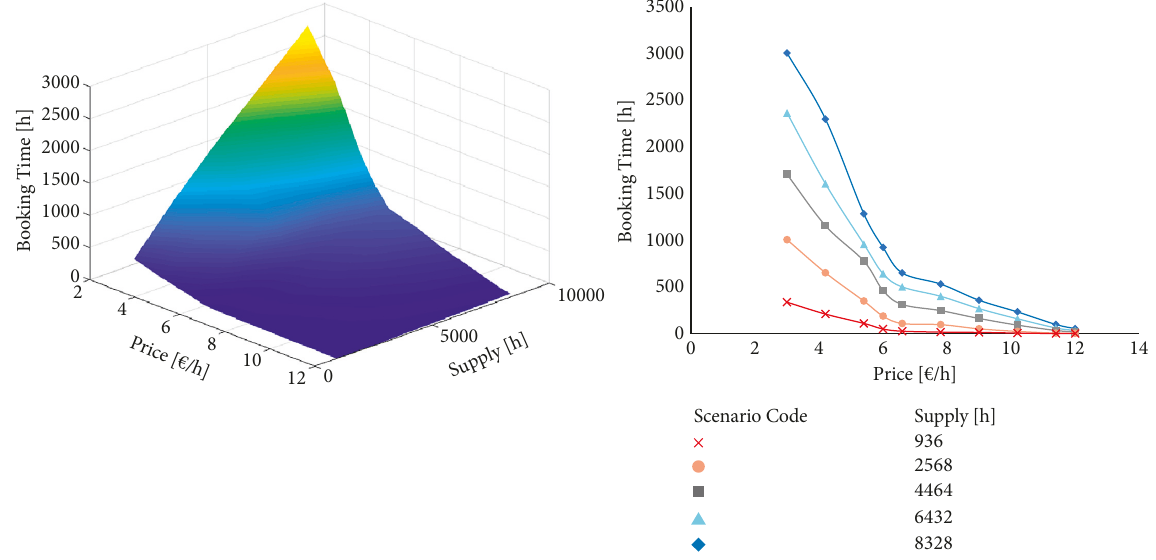
Figure 13: Demand elasticity.